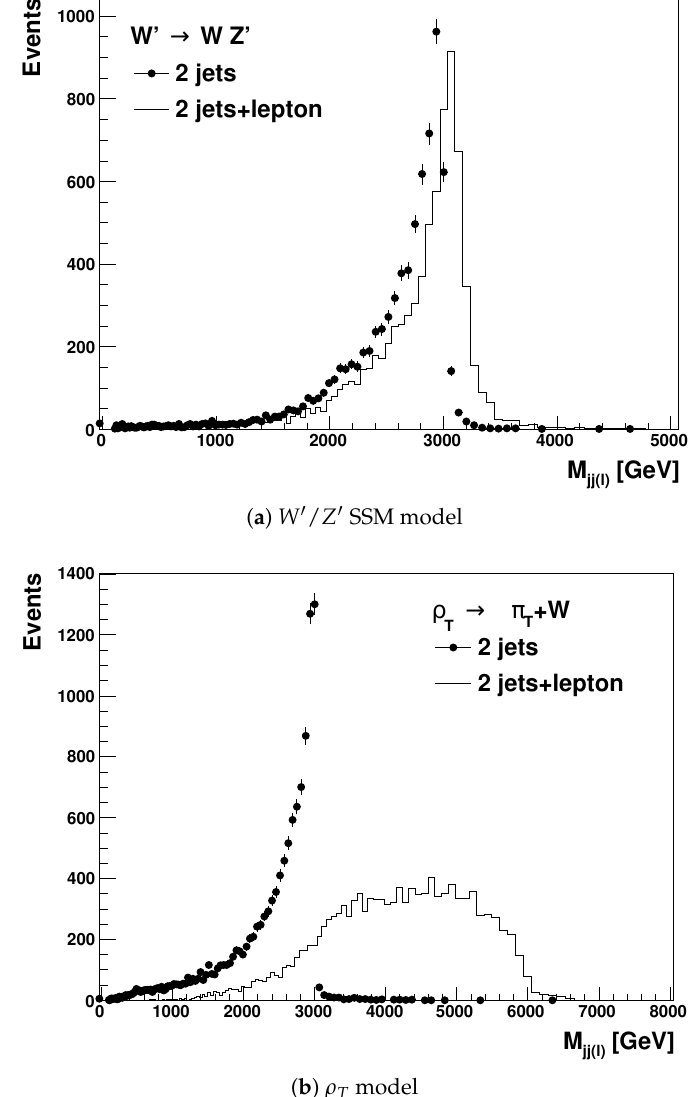
Figure 3. The invariant masses of two jets ( m jj ) and two jets and a lepton ( m jjl ) for ( a ) W (cid:48) → WZ (cid:48) → (cid:96) ν q ¯ q and ( b ) ρ → W ± π → (cid:96) ν q ¯ q process discussed in [17]. The SSM process has a mass splitting T T between W (cid:48) and Z (cid:48) of 250 GeV. The second model has a mass of the ρ T that is twice as large as that of the π T